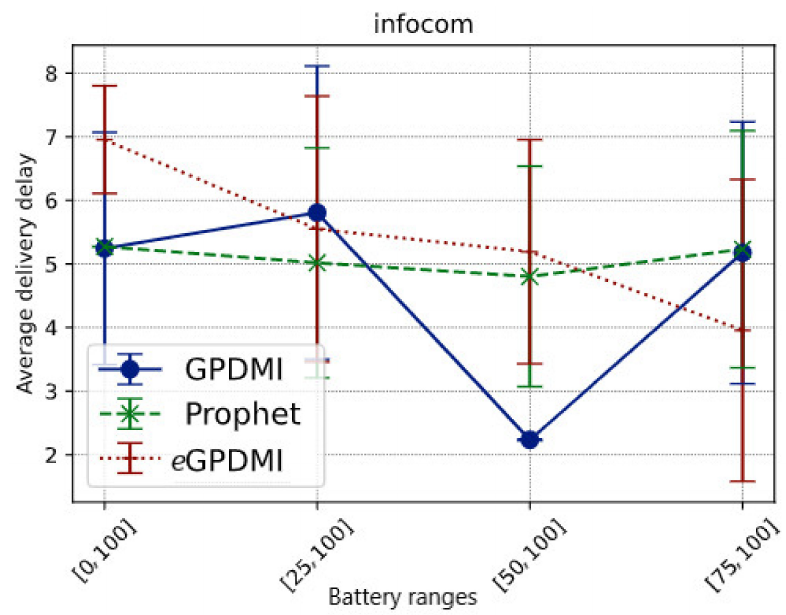
Figure 4. Average delivery delay vs. battery ranges in scenario Infocom.